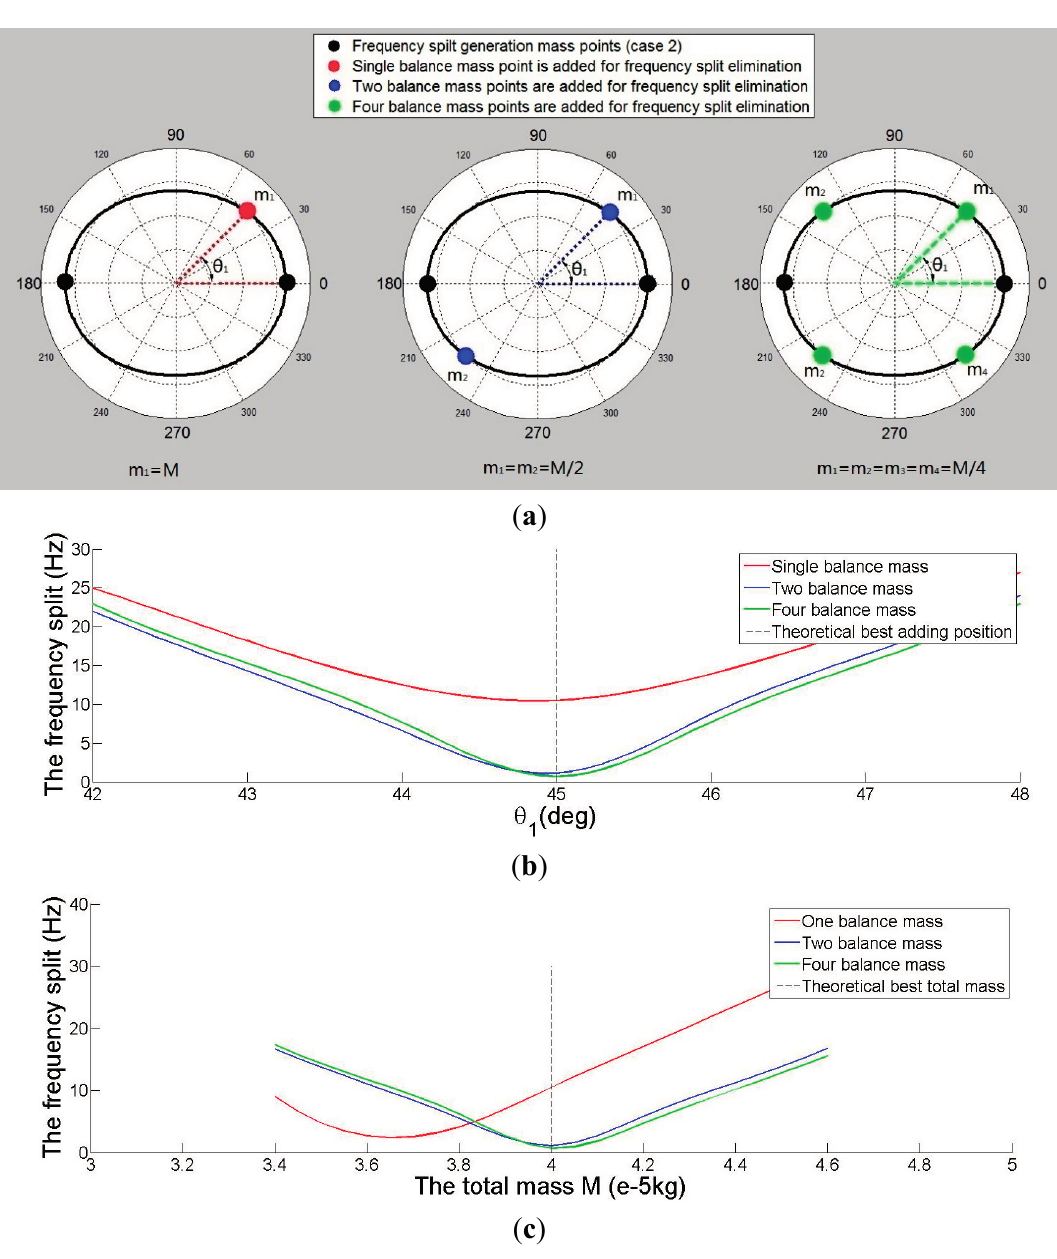
Figure 10. ( a ) The distribution of added mass points for eliminating frequency split Case 2; ( b ) The relationship between θ 1 and frequency split for eliminating frequency split Case 2 ( M = 0.04 g); ( c ) The relationship between mass of balance points M and frequency split for eliminating frequency split Case 2 ( θ 1 = π